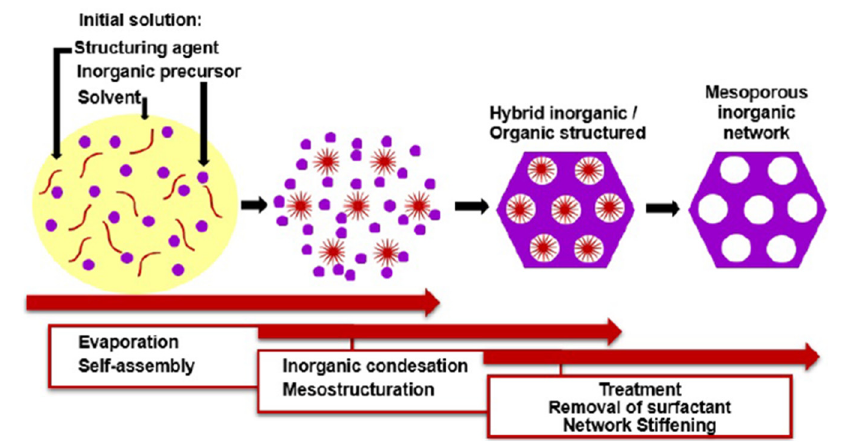
Figure 16. Schematic representation of EISA (Reprinted/adapted with permission from Ref. [115]).